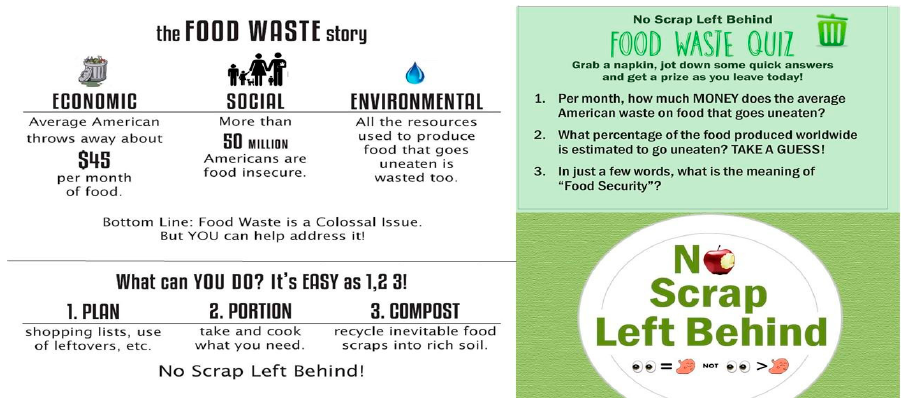
Figure 1. Examples of No Scrap Left Behind signage. Signage focused on economic, social, and environmental impacts of Figure 2. As students left the cafeteria, surveys were collected in exchange for a small prize (choices included reusable spork-knives, pens, mini-first aid kits, and candy). Quizzes, signage, surveys, and the food waste buffet were all opportunities to encourage student engagement in and interaction with program and program volunteers.